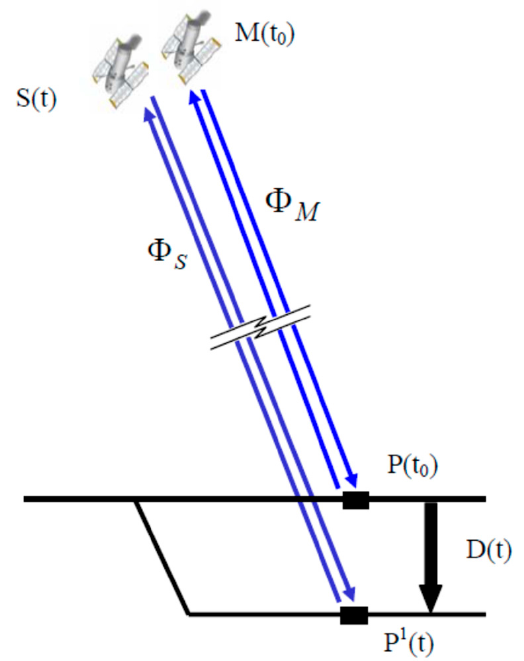
Figure 4. Displacement diagram of topographic relief and phase change of the signal [11].